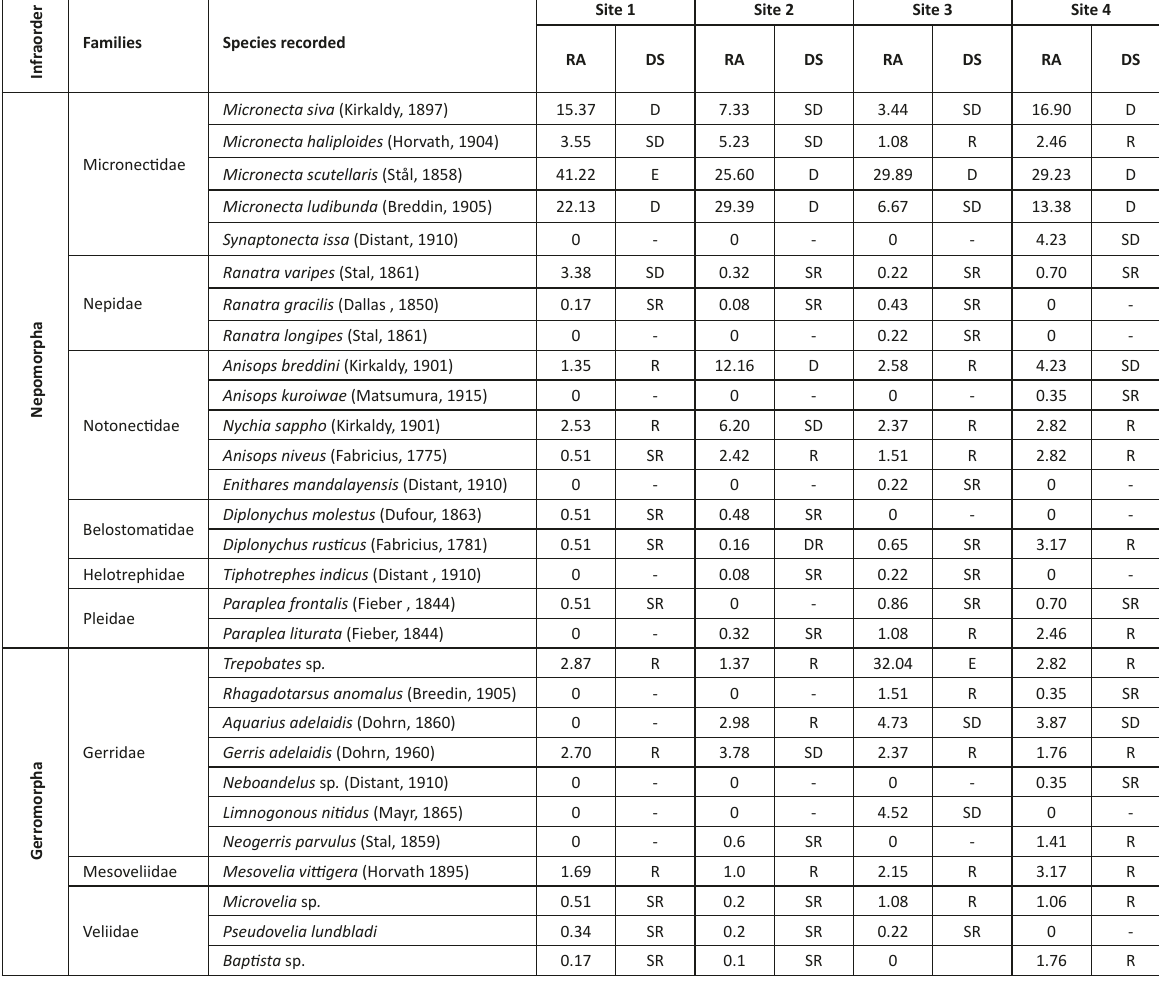
Table 1. Inventory of aquatic and semiaquatic Hemiptera along with their relative abundance (RA%) and dominance status (DS) (Engelmann’s scale, 1978) in the four study sites of Sonebeel e r r d Families a o f r I n